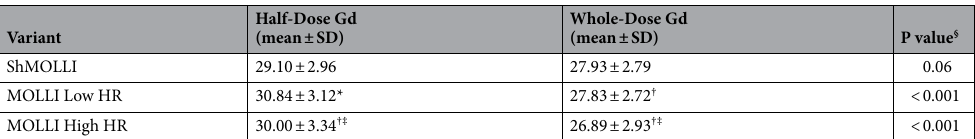
Table 2. Effect of gadolinium dose on ECV. * = P < 0.05 compared with ShMOLLI. † = P > 0.05 compared with ShMOLLI. ‡ = P > 0.05 compared with MOLLI Low HR. § = all P values reported at N = 44 samples (based on the maximum number of MOLLI samples per epoch) to assure fair inter-method comparison. ECV calculated as the cohort average per epoch.